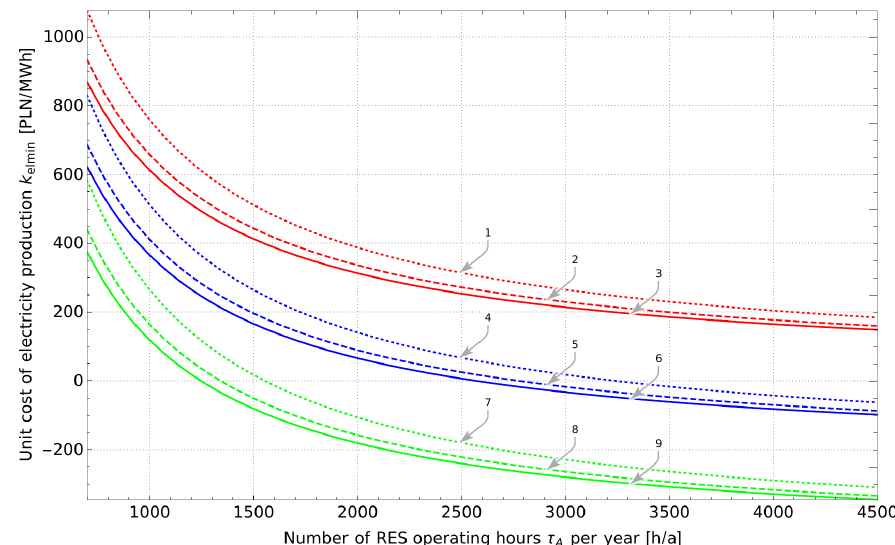
Figure 6. Unit cost of electricity production k elmin as a function of time τ A for τ 1 = 0 (1—